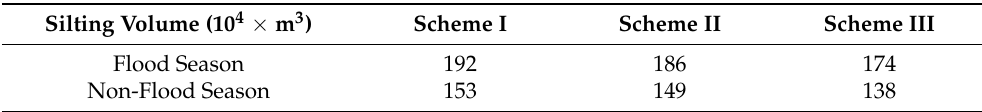
Table 1. Sediment deposition in different